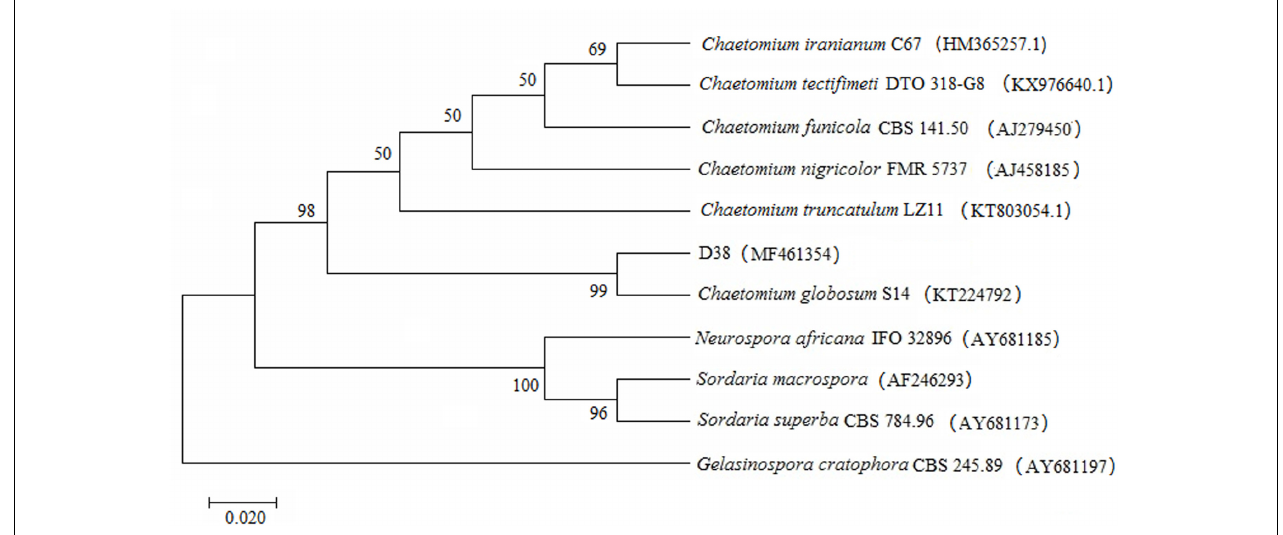
FIGURE 2 | Phylogenetic tree characterization of endophytic fungus D38. The tree presented is a neighbor-joining tree based on ITS gene sequence alignment, which showed the relationship between D38 and other fungi. The ITS gene sequence of D38 shared high homology with Chaetomium globosum . The tree was constructed with MEGA7 and 1000 bootstrap replicates based on Kimura 2-parameter model. And Gelasinospora cratophora (AY681197) is used as outgrout.